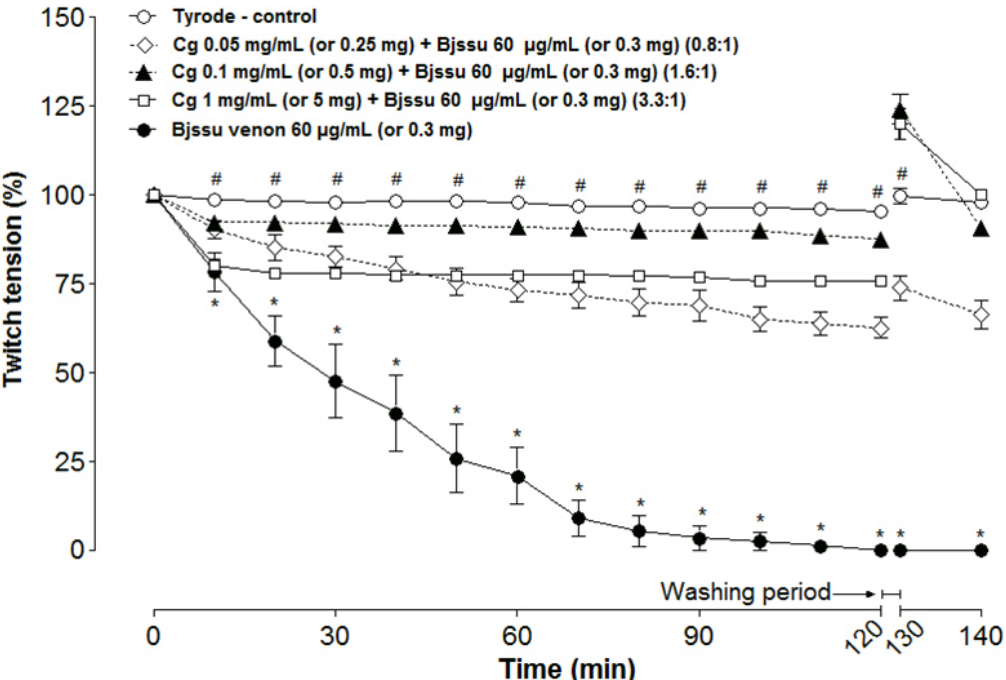
Figure 3. Twitch tension of mouse isolated phrenic nerve-diaphragm preparations under indirect stimuli, in percentage (each point represents the mean ± SEM, n = 6). Neuromuscular blockade by Bjssu venom (60 μg/mL or 300 mg or 0.3 mg) and assays of neutralization by Cg hydroalcoholic extracts (0.05, 0.1 and 1 mg/ mL or 0.25, 0.5 and 5 mg, respectively), compared to Tyrode solution (control) during 120 minutes. * p < 0.05 compared to Tyrode control for all periods (except 0). # p < 0.05 compared to Tyrode control and Bjssu